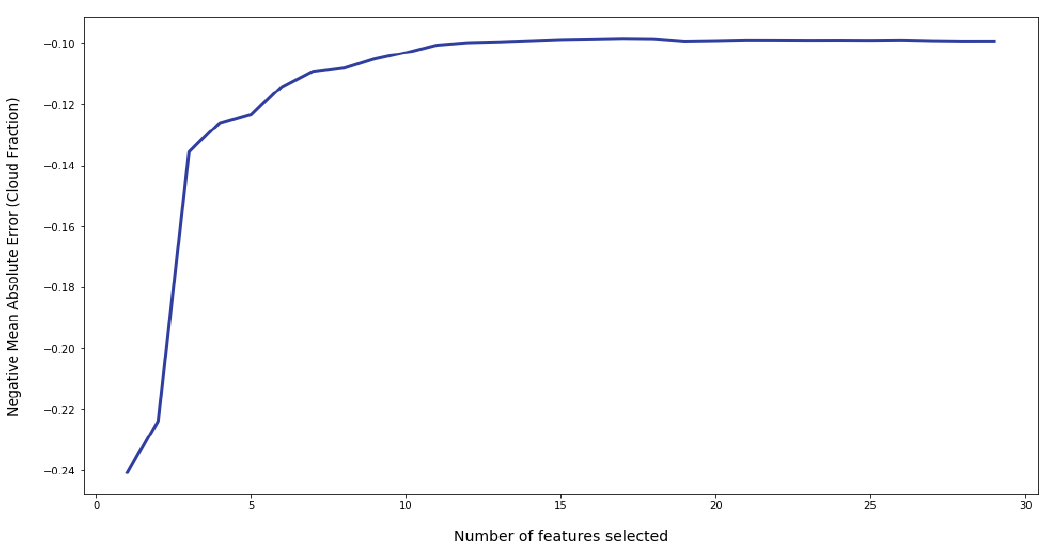
Figure 5. Recursive Feature Elimination that shows the negative mean absolute error as a function of number of features selected. The optimal number of features was determined to be 17 that had the lowest mean absolute error (MAE) (most negative MAE in plot).